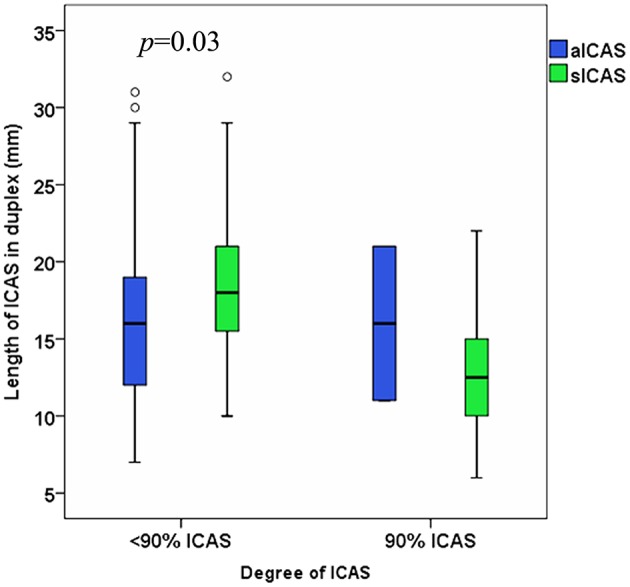
Difference between the ultrasound-measured length of sICAS and aICAS among patients with ICAS <90% vs. ICAS 90%. N.b. We had only two available arteries with aICAS 90%.